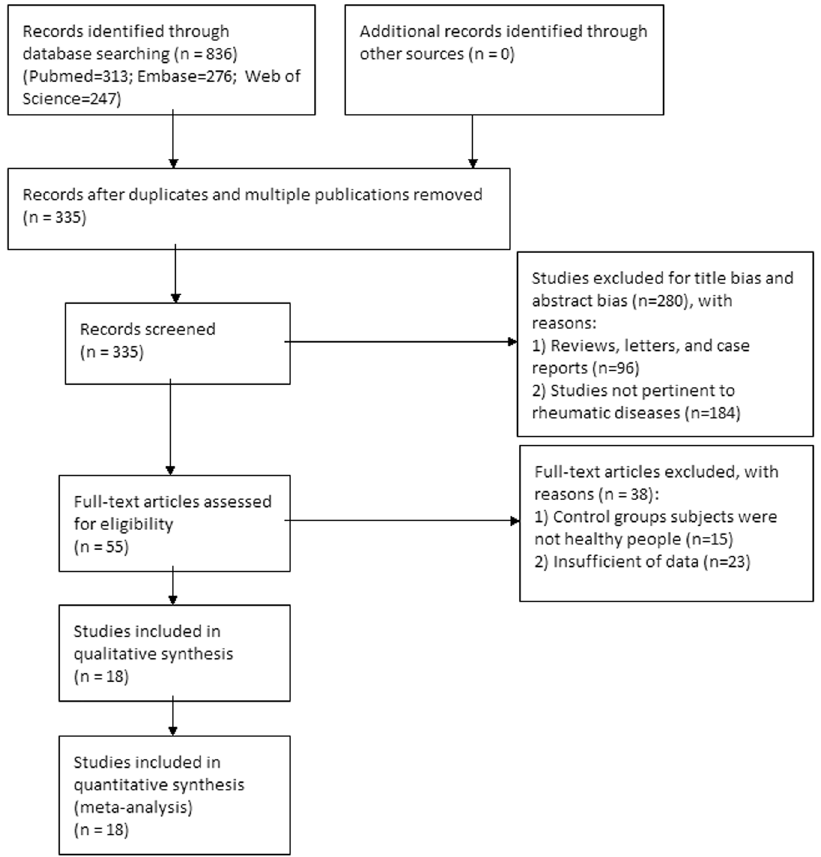
Figure 1. Flow chart of literature search and study